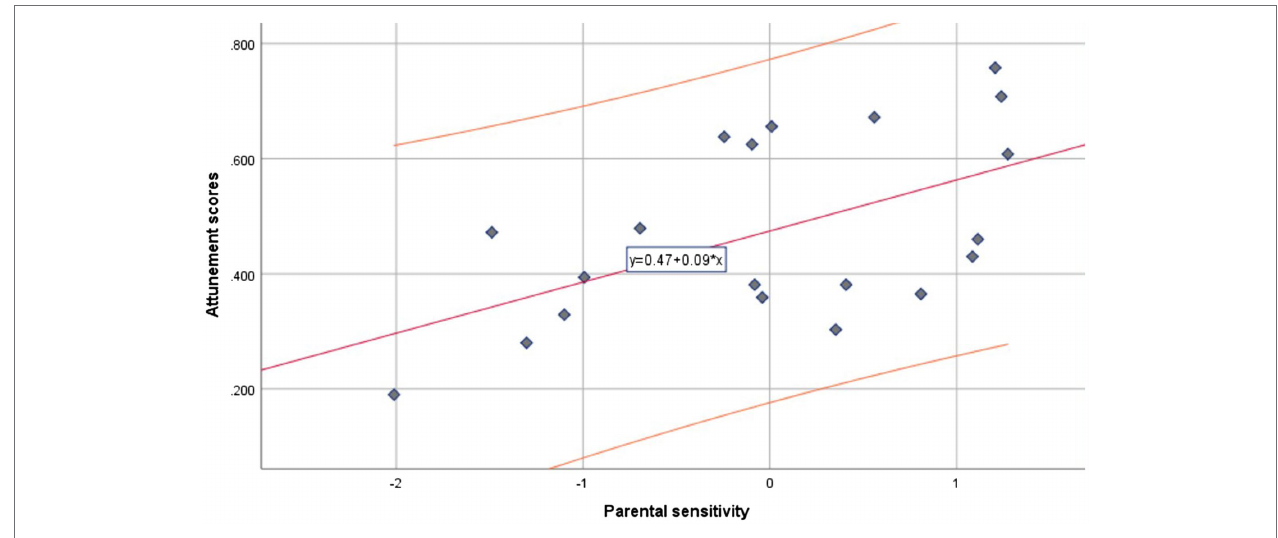
FIGURE 3 | VI sample. Regression slope (red) with confidence interval (orange) of the parental sensitivity scores ( x -axis) predicting attunement scores ( y -axis).